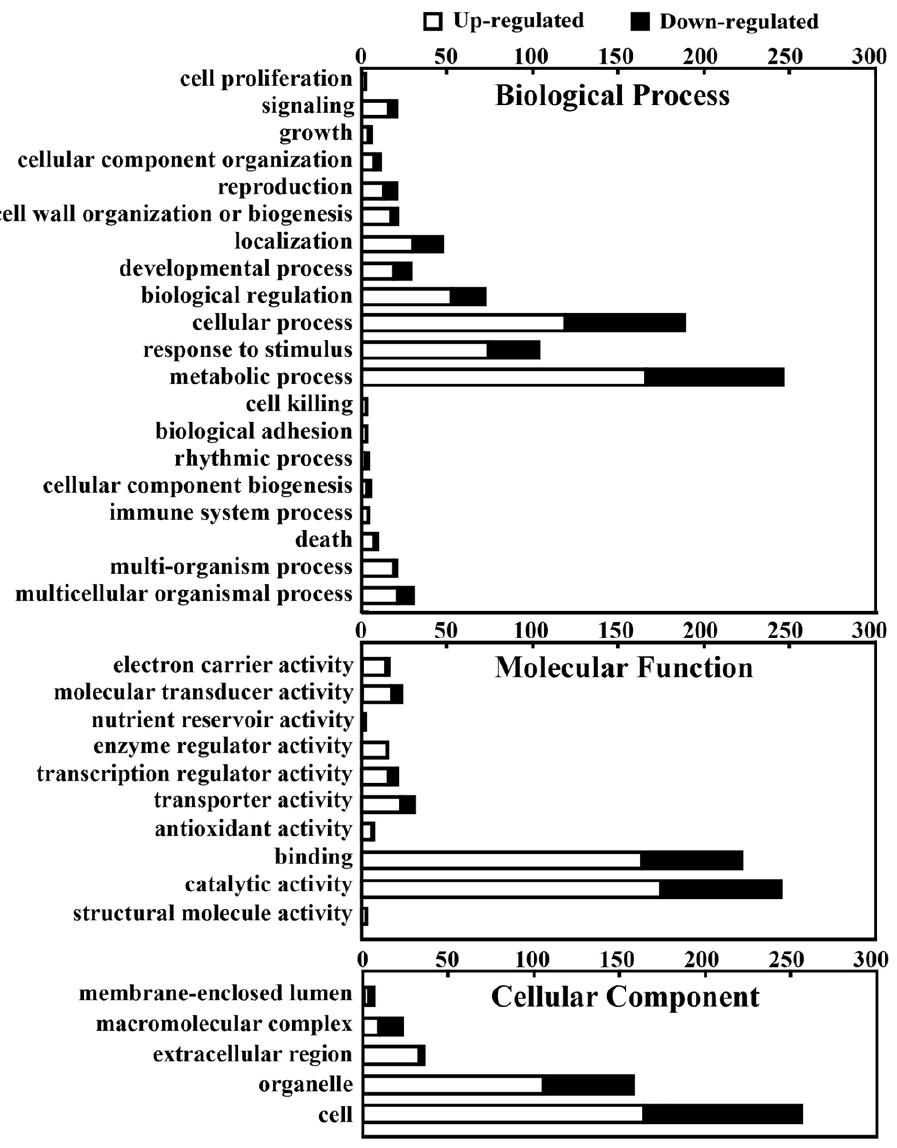
Figure 5. Functional categorization of 380 upregulated and 184 downregulated genes that are specifically regulated in ‘Meiwa’ based on GO annotation.